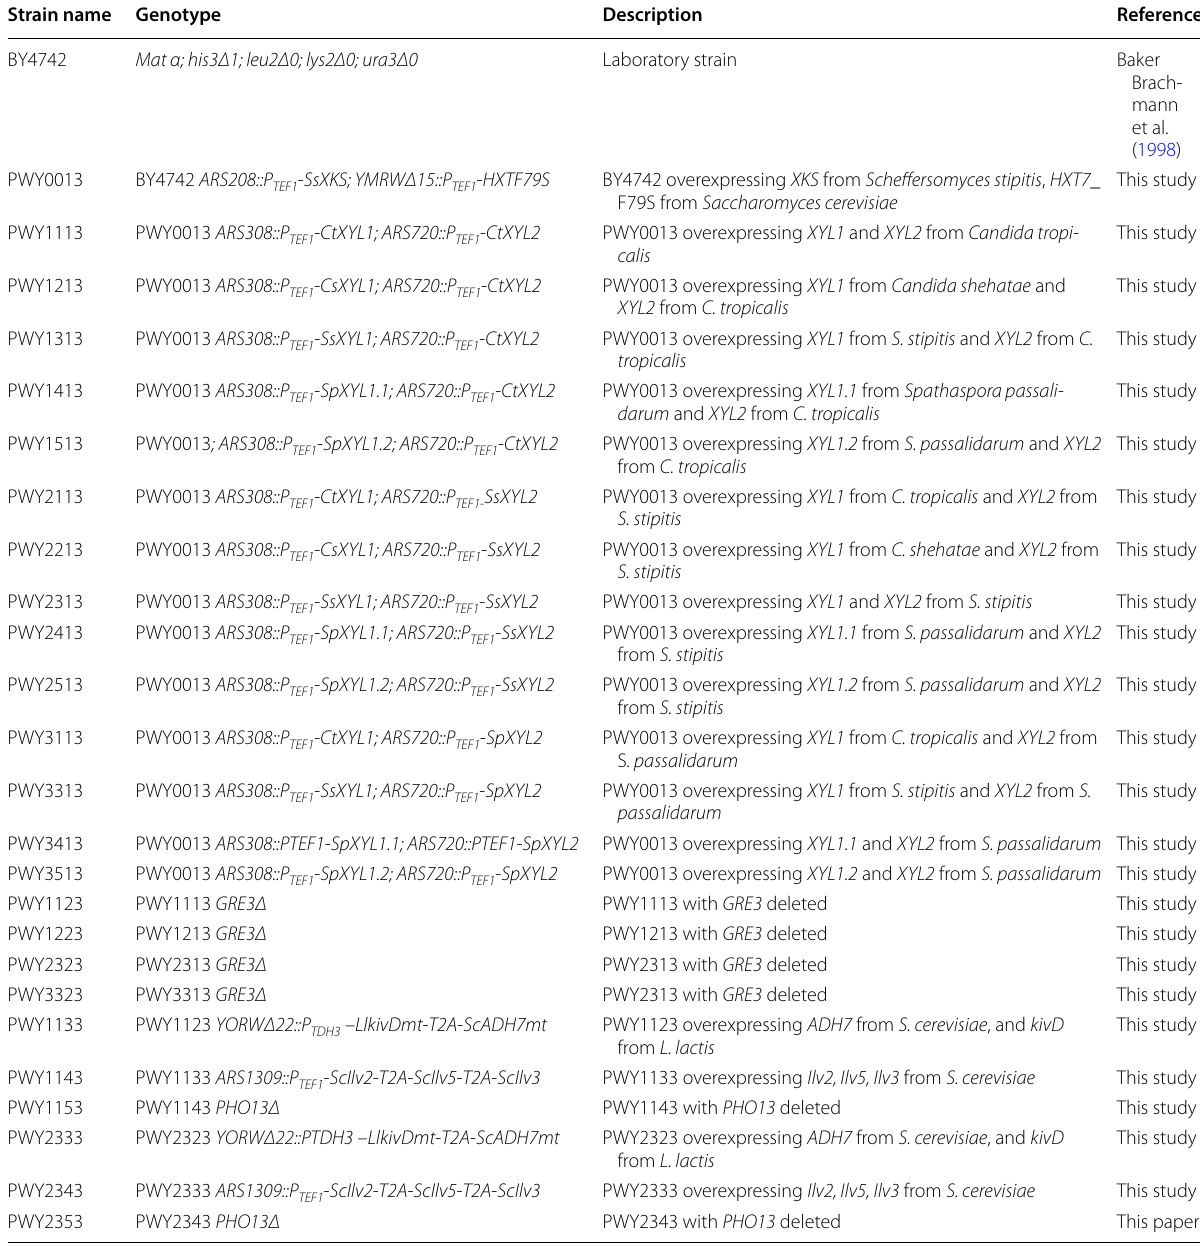
Table 1 Strains generated in this